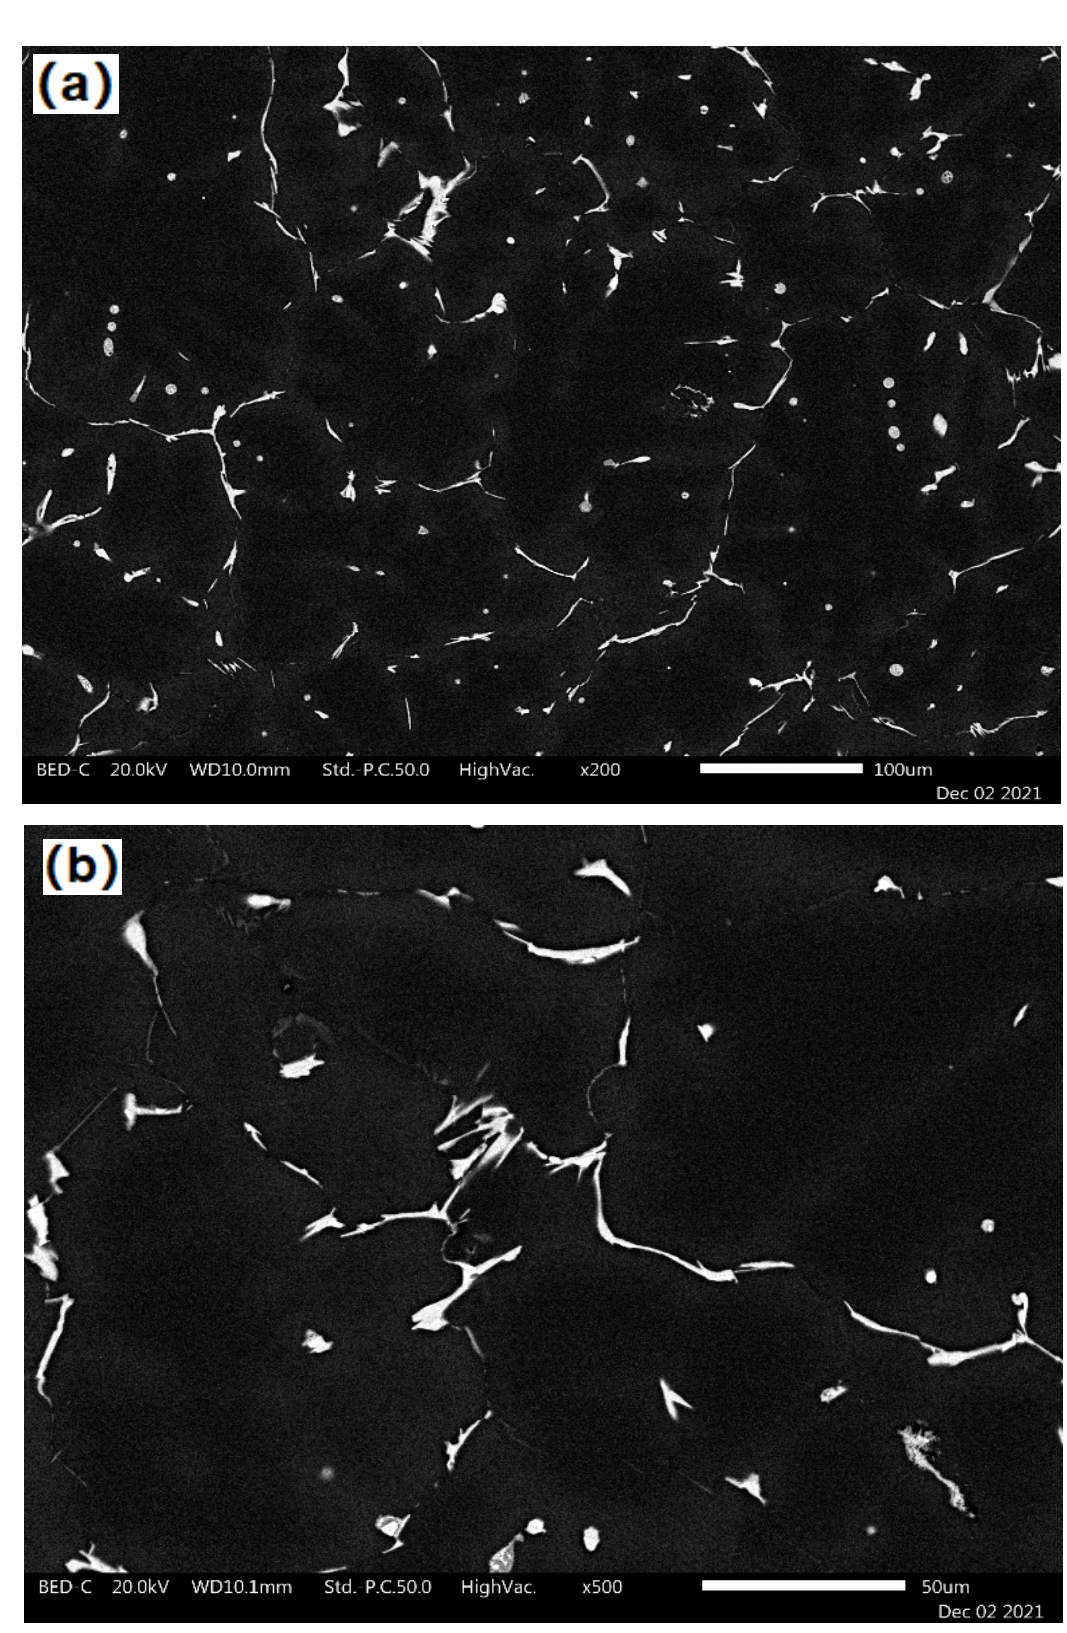
Figure 4. The casting microstructure of 2A97: ( a ) ×200; ( b ) ×500.